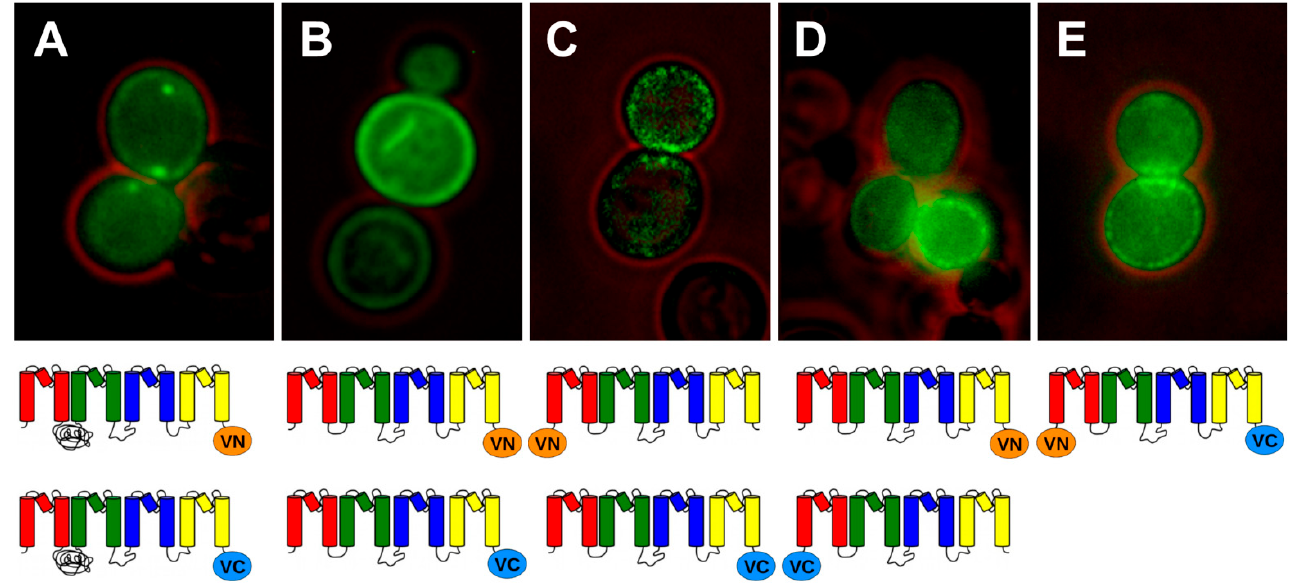
Figure 2. Trk1 monomers can interact, and LHL is not needed for association. ( A ) Trk1/VN + Trk1/VC; ( B ) Trk1[ Δ LHL]/VN + Trk1[ Δ LHL]/VC; ( C ) VN/Trk1[ Δ LHL] + Trk1[ Δ LHL]/VC; ( D ) VC/Trk1[ Δ LHL] + Trk1[ Δ LHL]/VN; and ( E ) VN/Trk1[ Δ LHL]/VC. Below the pictures schemes of the (combined) Trk1([ Δ LHL]) VC or VN fusions are shown.